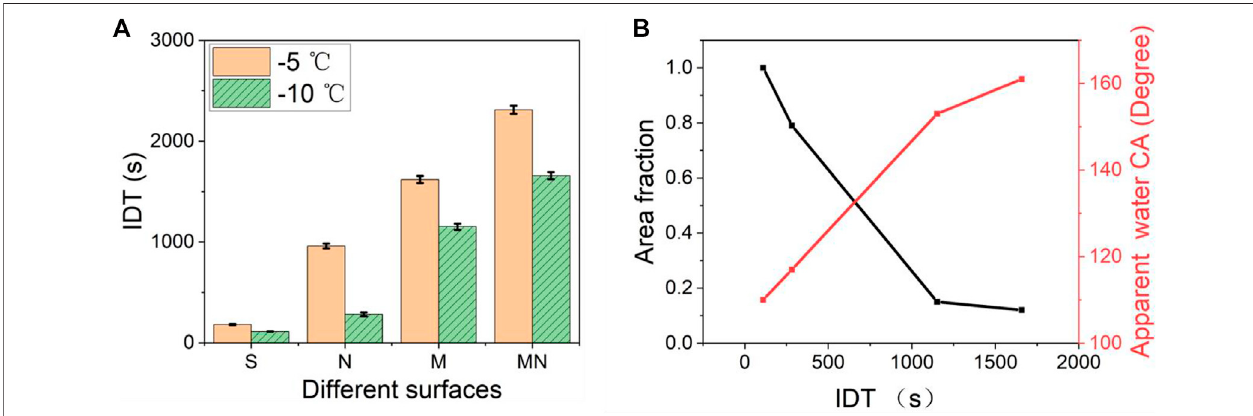
FIGURE8|(A) ShowsthecontrastontheIDTofthevariousstructuredsurfacesat − 5 ° Cand − 10 ° C.TheMNsurfaceshowsthelongestDTof2313±40 swhilethe S surface shows the shortest IDT of 180 ± 6 s (B) Shows the relationship between the area fraction, apparent water contact angle, and the IDT at − 10 ° . The apparent water contact angle is the sum of all the contributions of the liquid-solid and liquid-vapor interfaces as expressed in the Cassie – Baxter equation which is obtained using the contact angle goniometer and the ImageJ